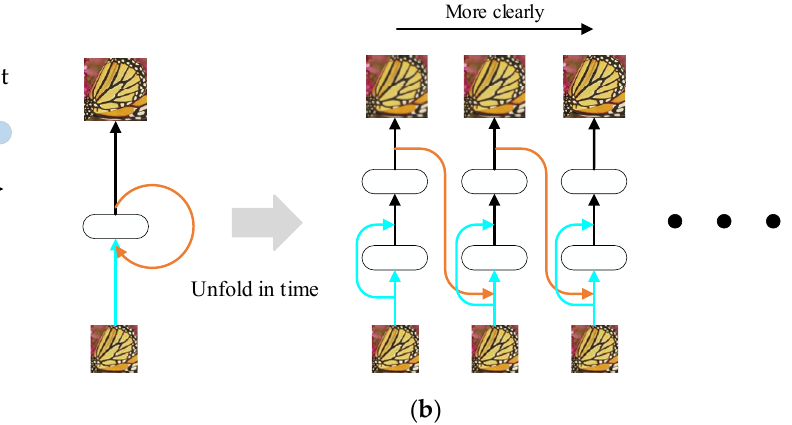
Figure 1. The illustration of the feedback mechanism in the proposed network. ( a ) Feedback is carried out through the hidden information in DLRRB in one iteration. ( b ) The principles of our feedback scheme, which gradually reconstruct a clearer image; orange arrows represent the feedback connection.